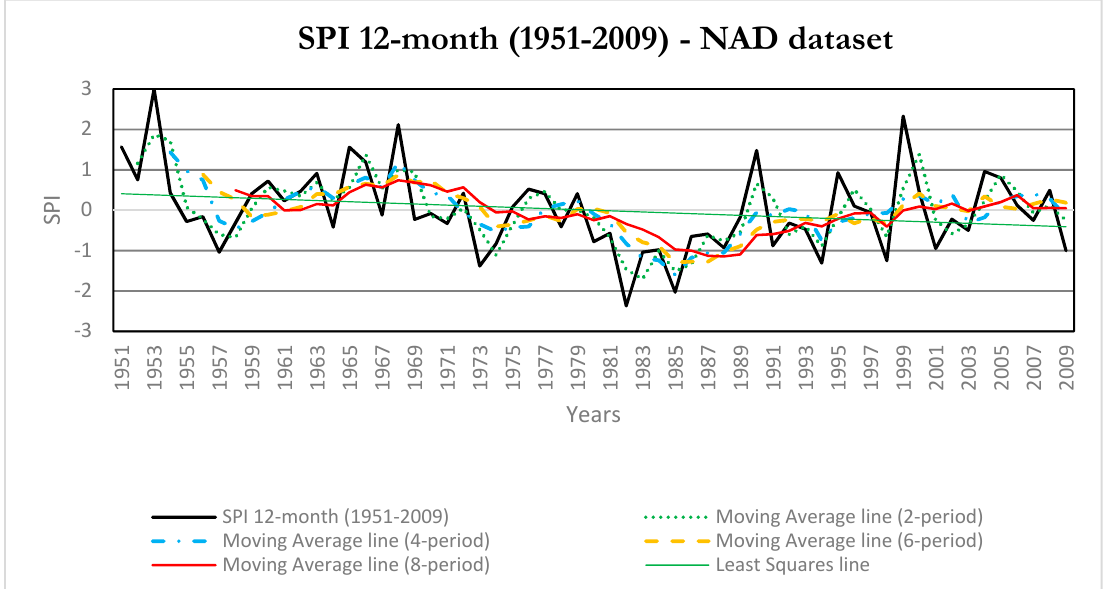
Figure 6. SPI 12-month (1950–2009) with tendency lines (Least Squares line and Moving average: 2-, 4-, 6-, 8-period)—NAD dataset.